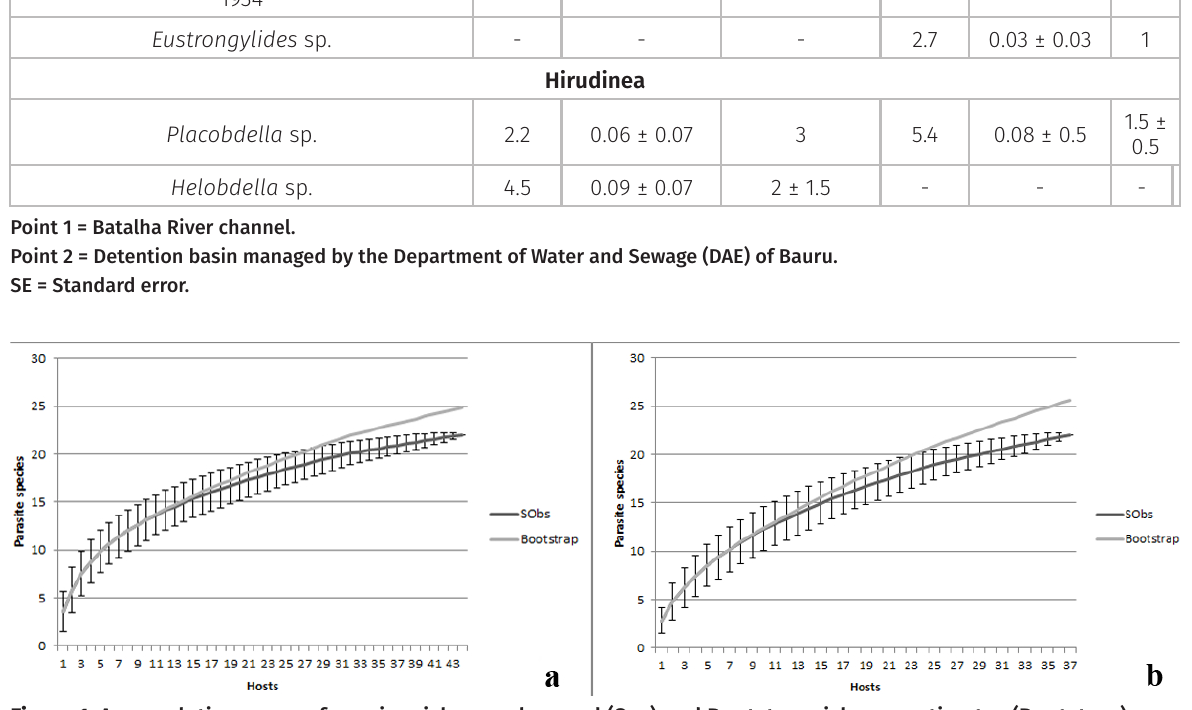
Figure 1. Accumulation curve of species richness observed (S ) and Bootstrap richness estimates (Bootstrap) Obs of the metazoan parasites in Hoplias malabaricus (Bloch, 1794) collected in the Batalha River in São Paulo State, Brazil. a) The river channel (Sampling Point 1); b) DAE reservoir (Sampling Point